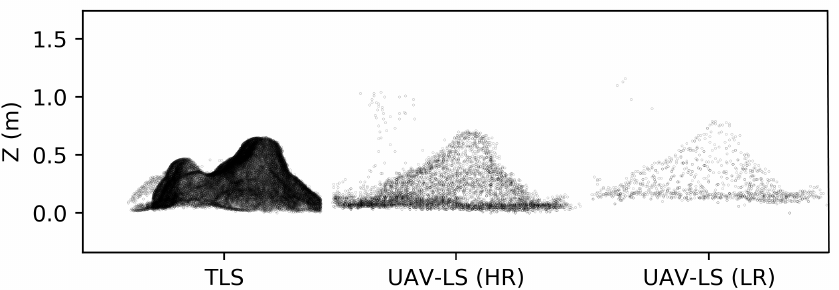
Figure 10. One termite mound, three different methods of acquisition. The point clouds consist of respectively 21,907, 5553 and 1107 points. All methods are able to adequately record termite mound shape.